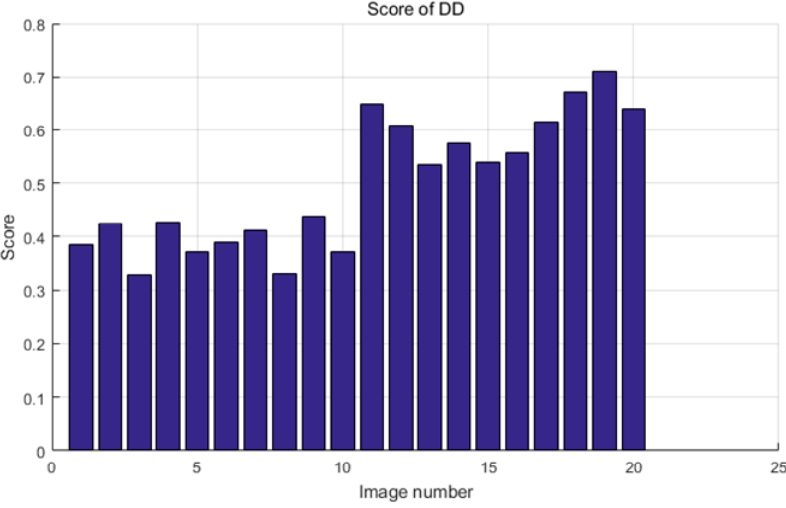
Figure 7. Distance determination (DD score).